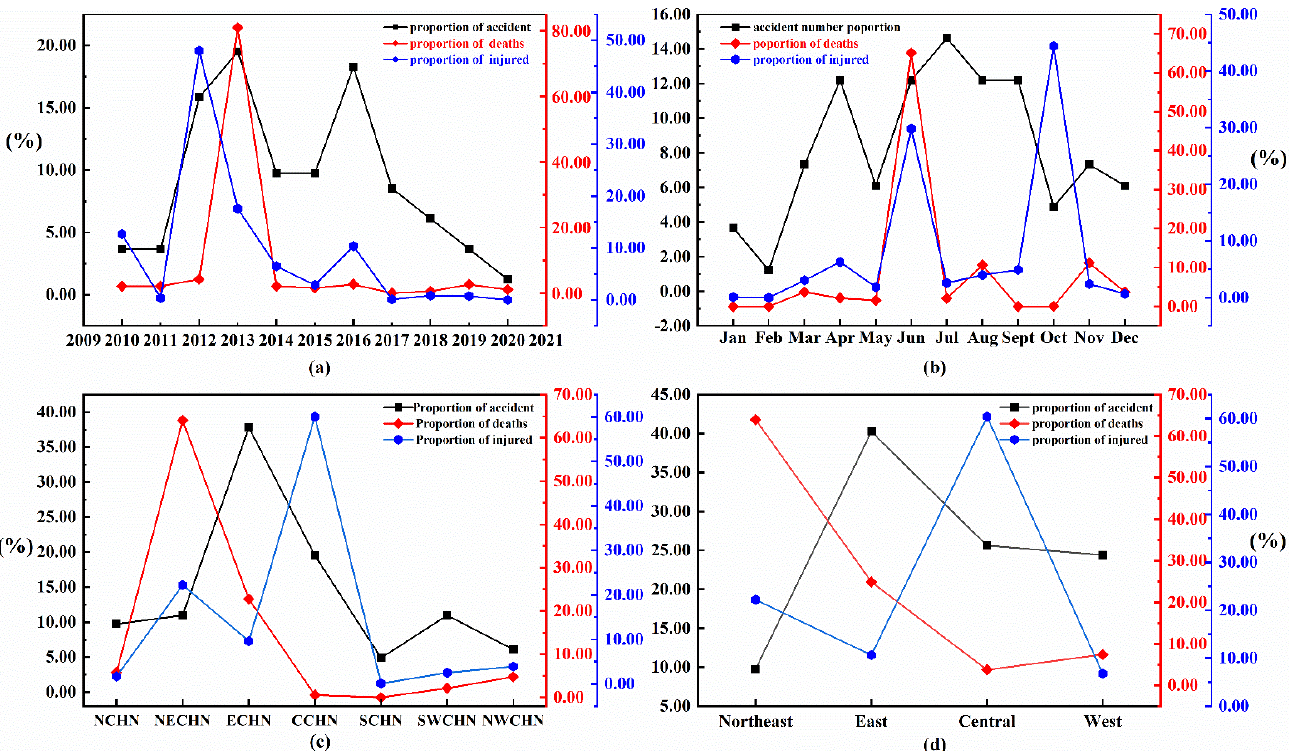
Figure 11. Variety trends between the number of accidents and casualties: ( a ) Variety trend by year; ( b ) Variety trend by month; ( c ) Variety trend by seven geographic regions; ( d ) Variety trend by four economic zones.